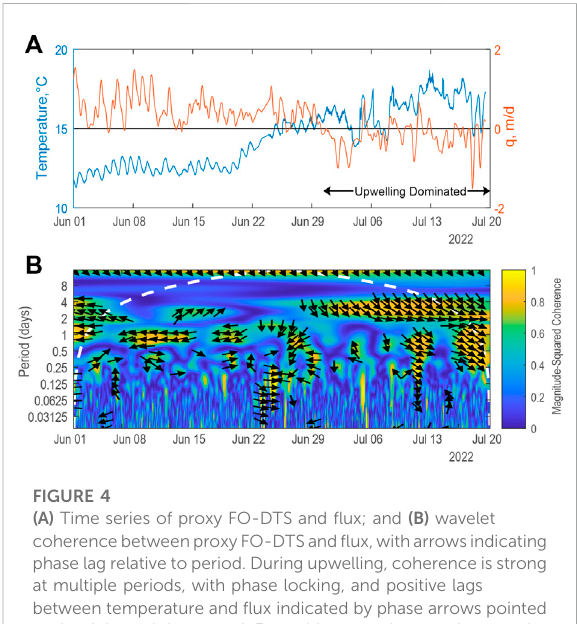
FIGURE 4 (A) Time series of proxy FO-DTS and fl ux; and (B) wavelet coherencebetweenproxyFO-DTSand fl ux,witharrowsindicating phase lag relative to period. During upwelling, coherence is strong at multiple periods, with phase locking, and positive lags between temperature and fl ux indicated by phase arrows pointed to the right and downward. For guidance on interpreting wavelet coherence plots, the reader is referred to Harmon et al.